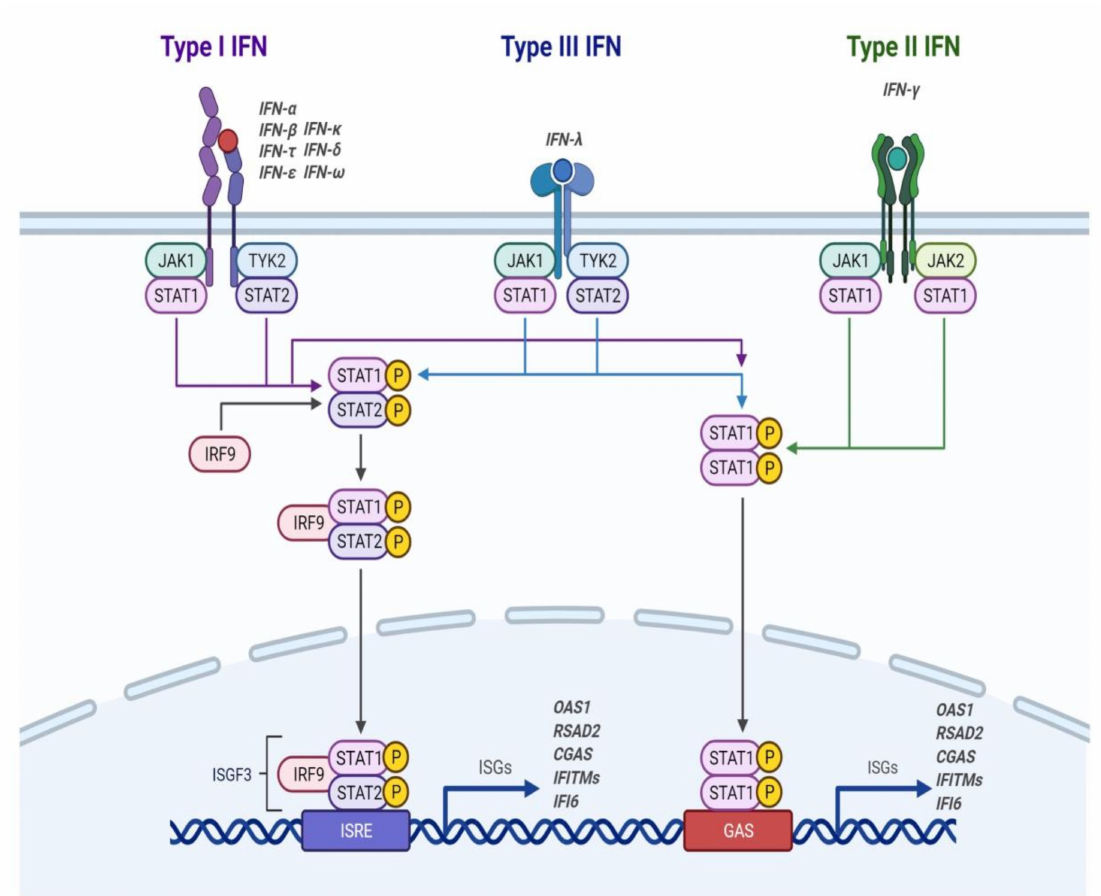
Figure 2. Activation of the IFN pathway. Within types I and III, there are multiple IFNs; within type II, there is a single IFN. Each type has a different heterodimeric cell surface receptor: type I IFNs bind to the IFNAR receptor complex (composed of IFNAR1 and IFNAR2); type III IFNs bind to the IFNLR receptor complex (composed of IFNLR1 and IL-10R β ). Binding of IFN to its receptor complex results in cross-phosphorylation of JAK1 and TYK2 in the cytoplasmic domains of the receptor subunits. This triggers the phosphorylation of STAT1 and STAT2. After phosphorylation, STATs form various complexes that translocate to the nucleus, where they bind to IFN-stimulated response elements (ISREs) or gamma-activated sequences (GAS) on ISG promoters. Binding to these promoter elements results in the transcription of hundreds of genes involved in the antiviral response, including OAS1, -2, -3, RSAD2, CGAS, IFITMs (-1, -2, -3, -5) and IFI6, among others, which will control the infectious process. Figure created using